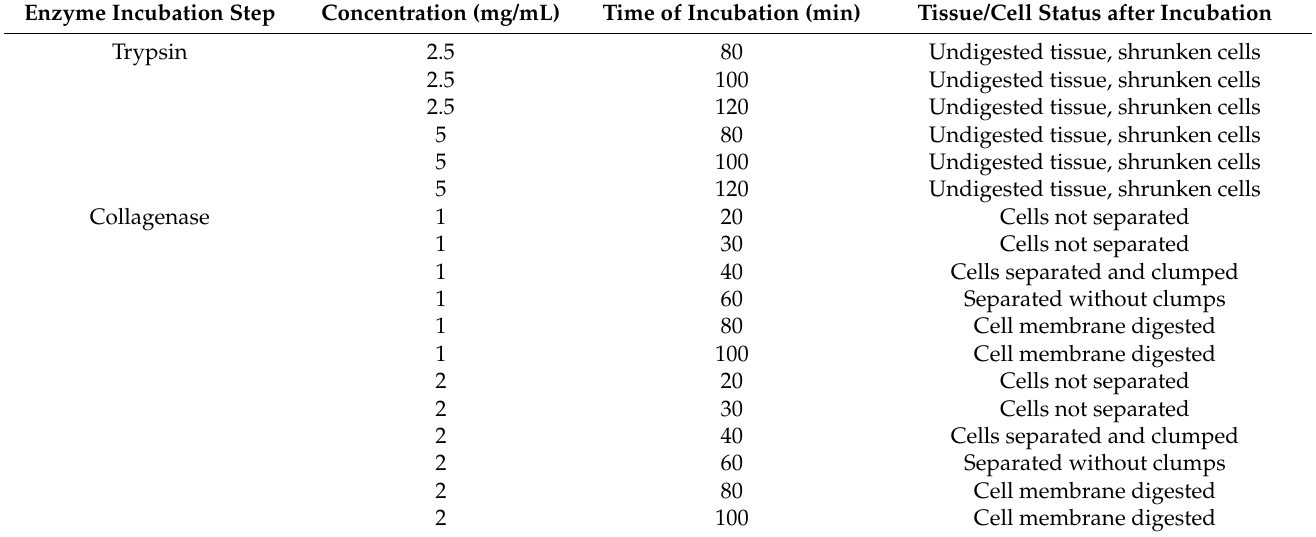
Table 1. Parameters tested in the protocol optimisation process and the results with descriptions of tissue or cell status after